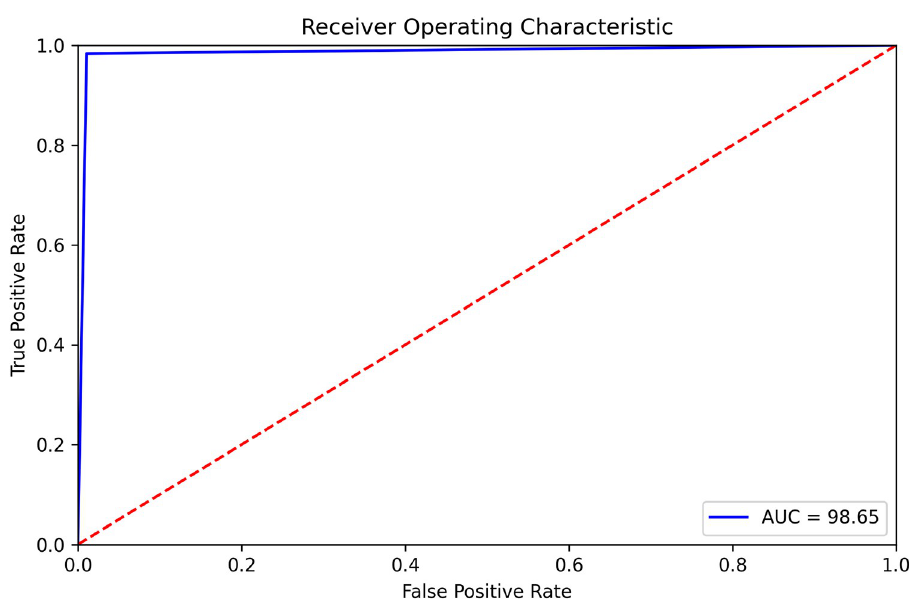
Fig 27. ROC curve of best configured model (Adam